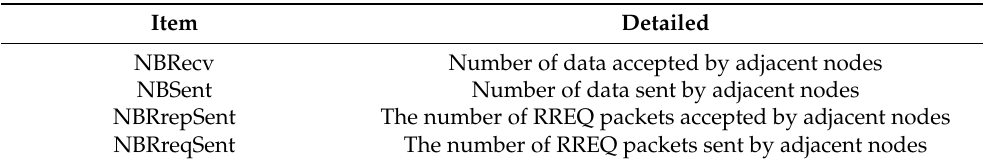
Table 1. Traffic characteristics of adjacent nodes.